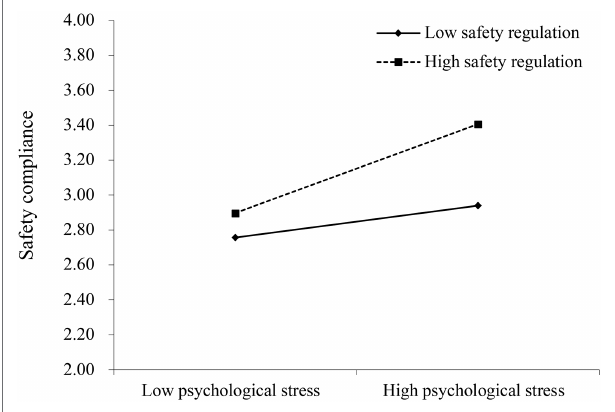
FIGURE 3 | Moderation effect of perceived safety regulation on relationship between psychological stress and safety compliance.